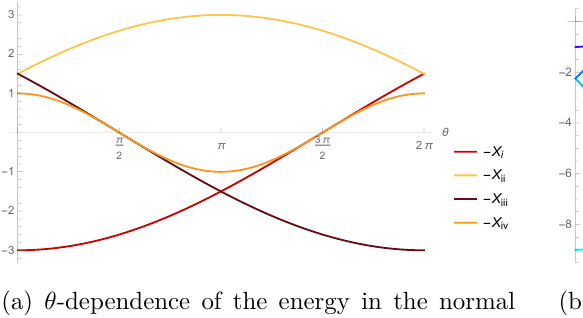
phase for N = 3 . f Figure 3 . θ -dependence of the energy for N f = 3